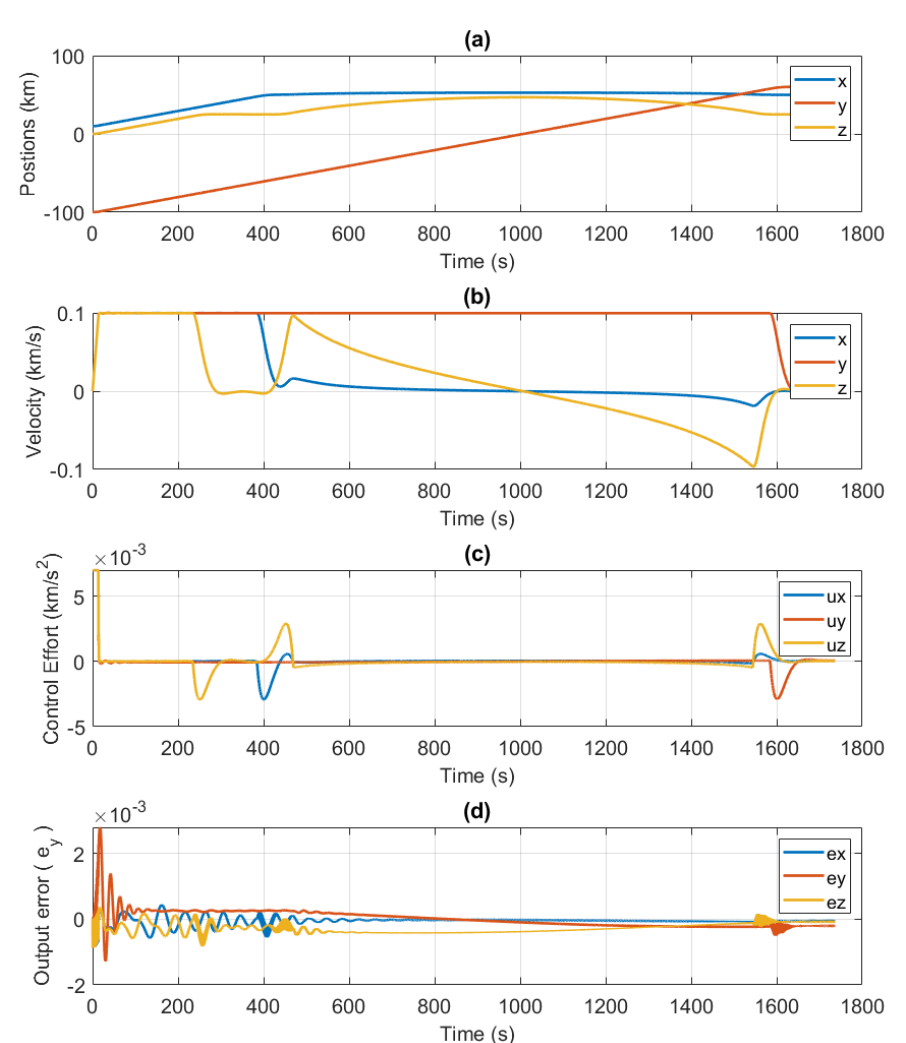
Figure 11. Plots for DAMPC case for asteroid Kleopatra: ( a ) position vs. time; ( b ) velocity vs. time; ( c ) control effort vs. time; ( d ) output error vs.